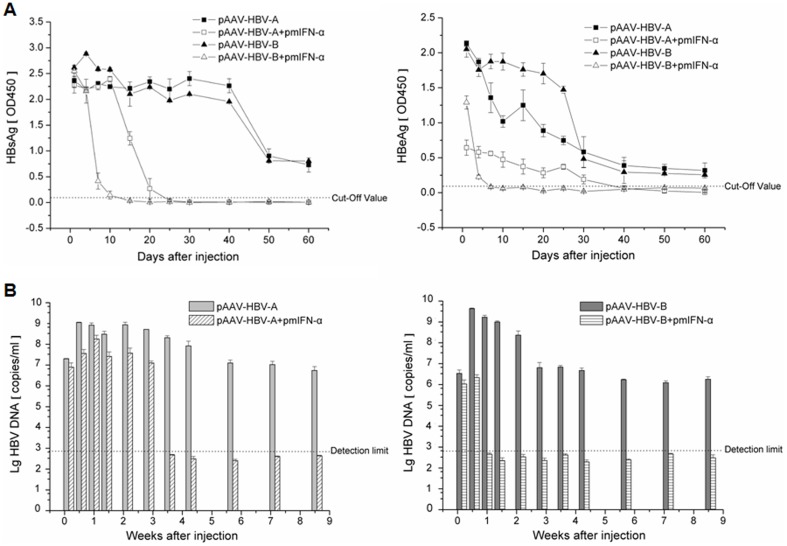
Kinetics of HBsAg, HBeAg and HBV DNA in sera of the mice after HI.10 µg of pAAV-HBV-B alone or combined with 20 µg pmIFN-α were used for HI. (A) HBsAg and HBeAg levels in the sera of C57BL/6 mice after HI. The value of OD450 ≥ Cut-Off value means the sample was positive. (B) Real-time PCR detection of HBV DNA levels in the sera of the mice after HI, dotted line indicates detection limit. At least three mice per group were analysed.